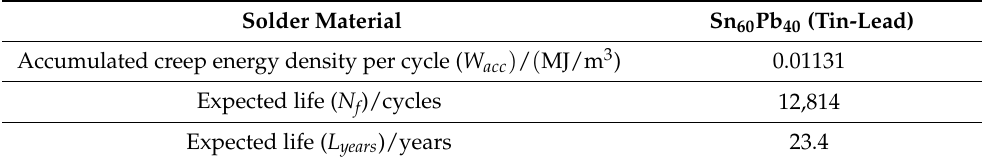
Table 5. Expected life of solder interconnects from outdoor module (TRA) temperature cycle